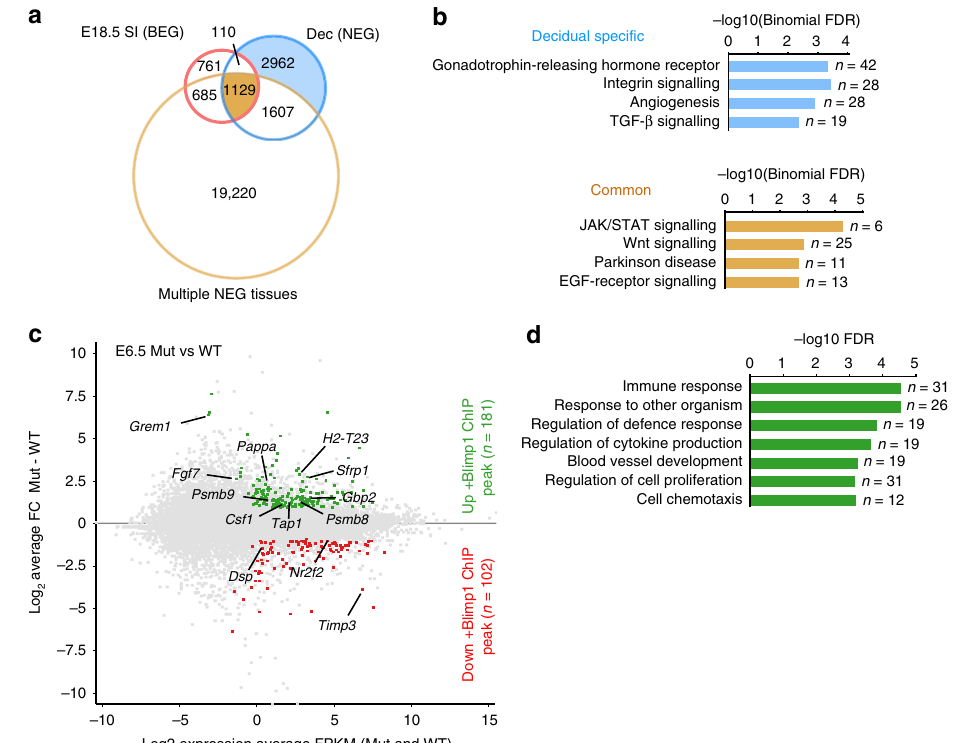
Fig. 5 ChIP-Seq analysis of E6.5 decidua identi fi es potential Blimp1 target genes. a Venn diagram overlaps of genome-wide Blimp1 binding sites identi fi ed by ChIP-Seq analysis of; E6.5 NEG decidua ( n = 5808); multiple other NEG mouse tissues 21 ( n = 22,641); and embryonic small intestine from BEG mice 22 ( n = 2685) identi fi es decidual-speci fi c and common Blimp1 binding sites. b Over-represented gene categories associated with common ( n = 1129) and decidual-speci fi c Blimp1 ChIP peak subsets ( n = 2962) within 100 kb of gene TSSs based on PANTHER pathway as analysed using GREAT V3.0 bionomial test with multiple testing correction. The number of genes associated with each gene category are indicated. c MA plot of E6.5 Blimp1 mutant vs wild-type decidual RNA-Seq pro fi les with up- (green) and down-(red) regulated E6.5 NEG Blimp1 target genes indicated. Candidate Blimp1 target genes with potential links to mutant decidual abnormalities are highlighted. d Over-represented gene categories among upregulated Blimp1 target genes based on GO Biological process with af fi nity propagation as analysed using Webgestalt 2019 with Benjamini-Hochberg multiple testing correction. The number of genes associated with each gene category are